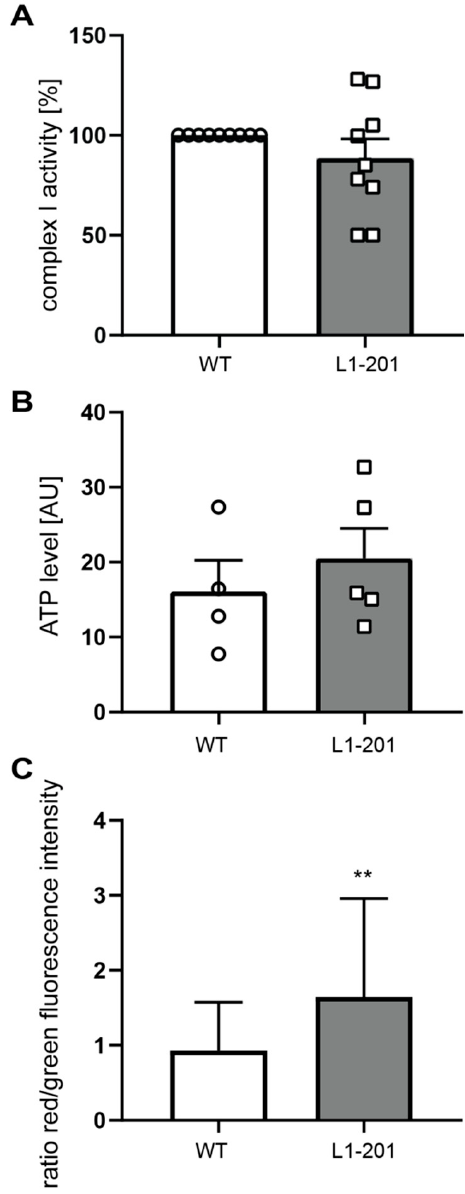
Figure 6. Normal Complex I activity, normal ATP levels and higher membrane potential in mito- chondria from L1-201 mice. ( A ) Mitochondrial Complex I activity was determined using isolated mitochondria from whole brains of 7- to 9-day-old male L1-201 (gray bars) and wild-type (WT, white bars) littermate mice (n = 9 mice per group). ( B , C ) Mitochondrial ATP levels ( B ) and mitochondrial membrane potential ( C ) were determined in cultured cerebellar neurons from 7-day-old male L1-201 (gray bars) and wild-type (WT, white bars) littermate mice (n = 4 mice per group). Means ± SEM and values from individual mice are shown for Complex I activity and ATP levels ( A , B ) and means ± SD for membrane potential ( C ); n = 3. ** p < 0.01 (membrane potential: Student´s t -test; Complex I activity and ATP levels: Mann–Whitney test).